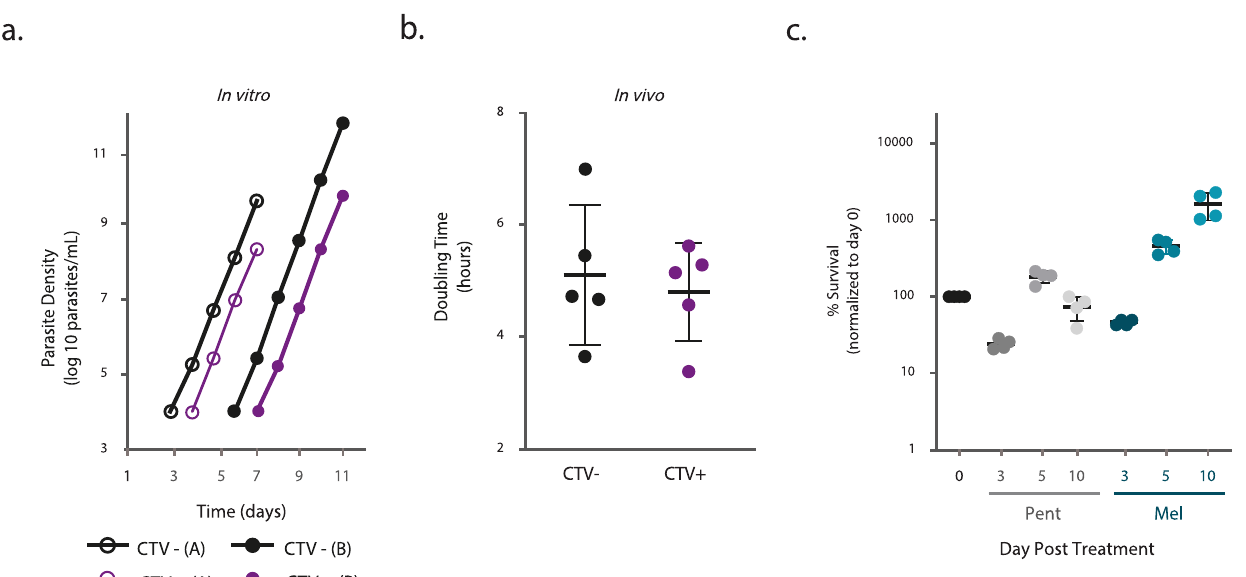
Fig.5|CharacterizationofslowgrowingATFs.a Invitrogrowthcurvesofsorted CTV negative (CTV-; black) and positive (CTV+; violet) parasites isolated from adiposetissueofmiceinfectedfor3dayswithculturedLister427parasiteslabeled withCTVimmediatelypriortoinfection( n =2independentexperiments). b Invivo doubling times of sorted CTV negative (CTV − ; black) and positive (CTV+; violet) parasites isolated from adipose tissue of mice infected for 3 days with cultured Lister 427 parasites labeled with CTV immediately prior to infection ( n =5 inde- pendent experiments). Black lines represent the average values and error bars the